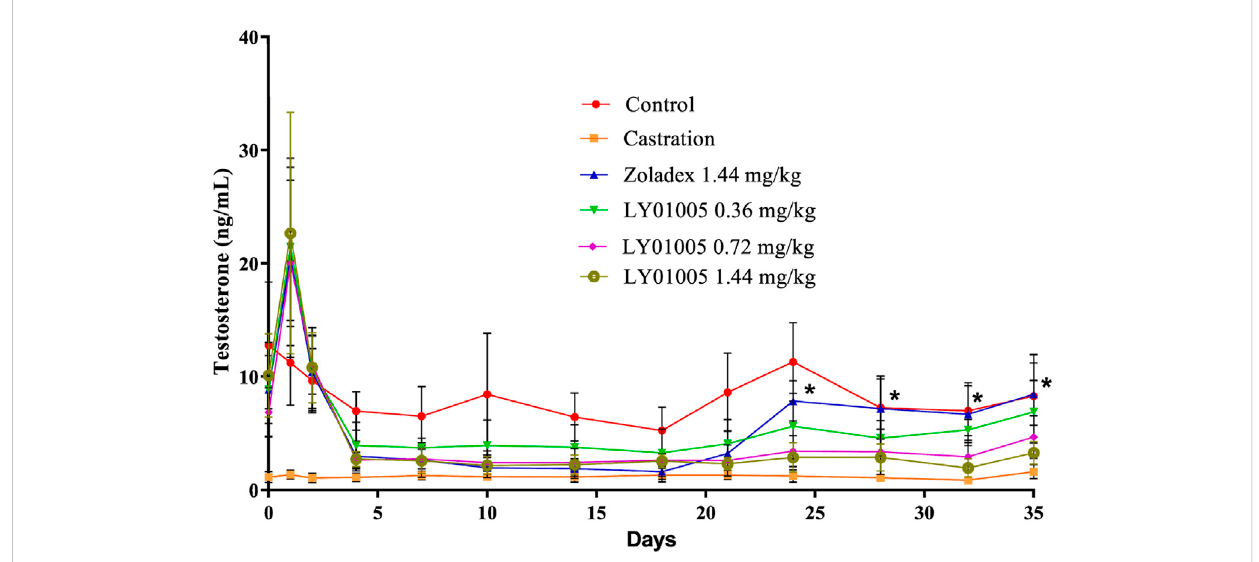
FIGURE 1 Effects of LY01005 on serum testosterone levels in male rats. *, p < 0.05 , LY01005 compared to Zoladex ® at the same